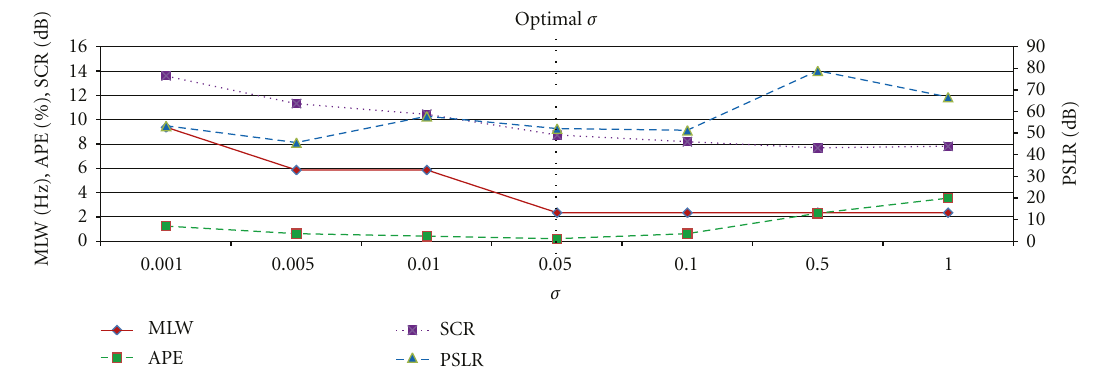
Figure 5: Performance comparison of the TFR using CWD with various σ for sag signal. Table 5: Performance comparison of